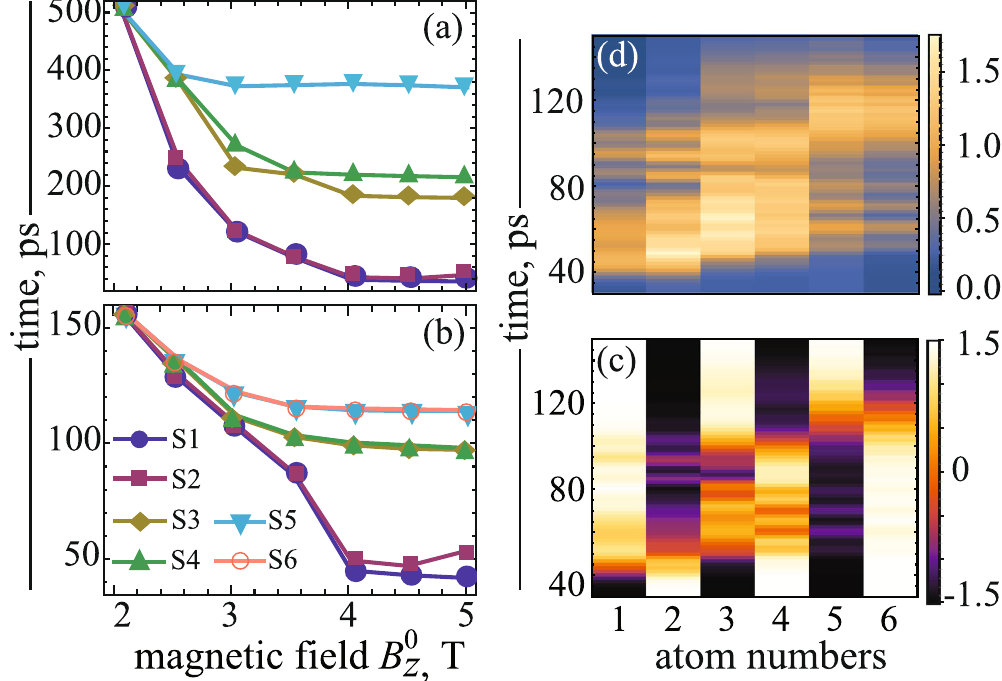
Figure 5. Dependence of a spin reversal time [( a ) and ( b )] for 5- and 6-atomic chains, respectively, with exchange parameter J = − 0.1 meV on the external magnetic field amplitude B < S > spin components and ( d ) a single-particle Von Neumann entropies between neighboring spins for z 6-atomic chain, respectively.